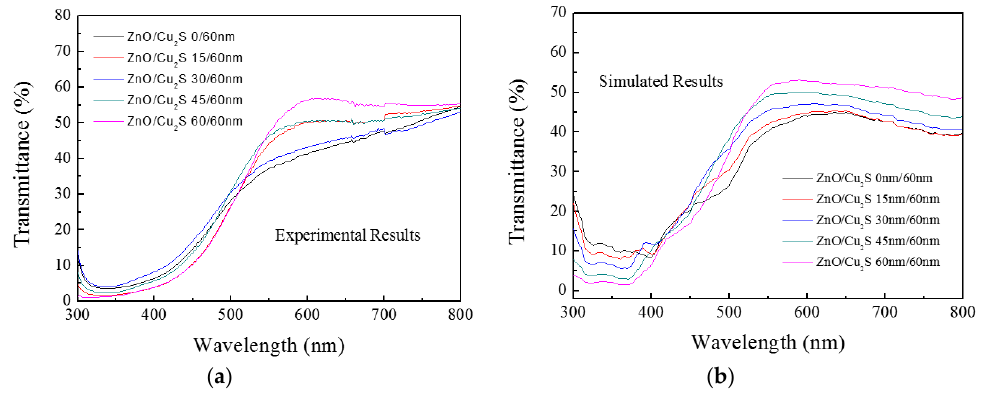
Figure 21. ( a ) is experimental results of ZnO/Cu 2 S/glass film and ( b ) is simulated results of ZnO/Cu 2 S/glass film.